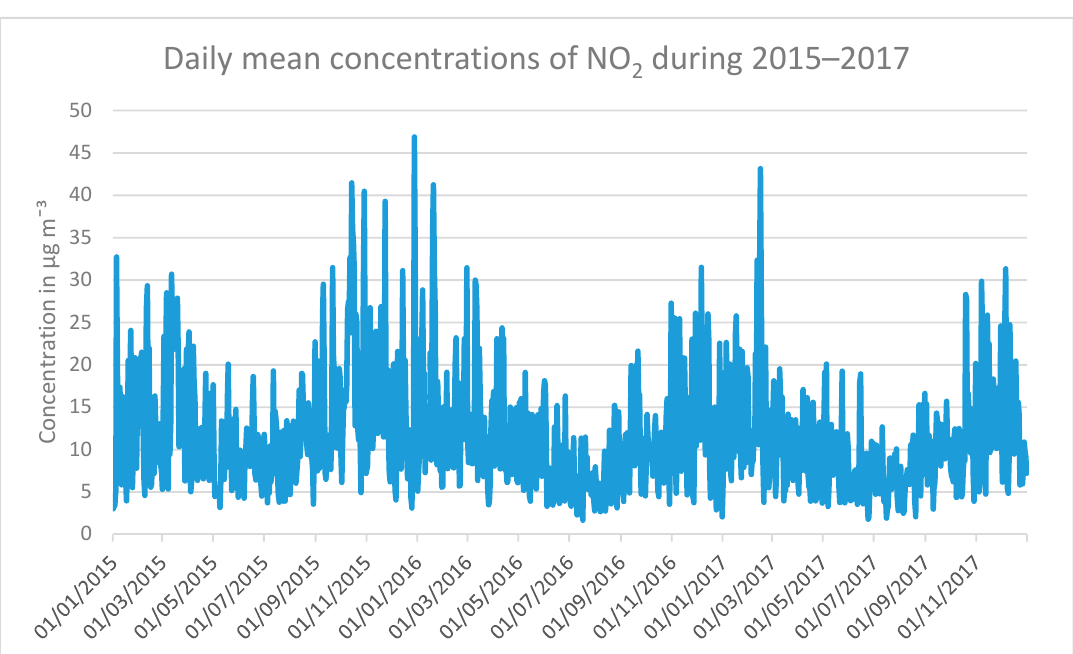
Figure A1. Daily mean concentrations of NO 2 at an urban background station in Stockholm during the period of 2015–2017.